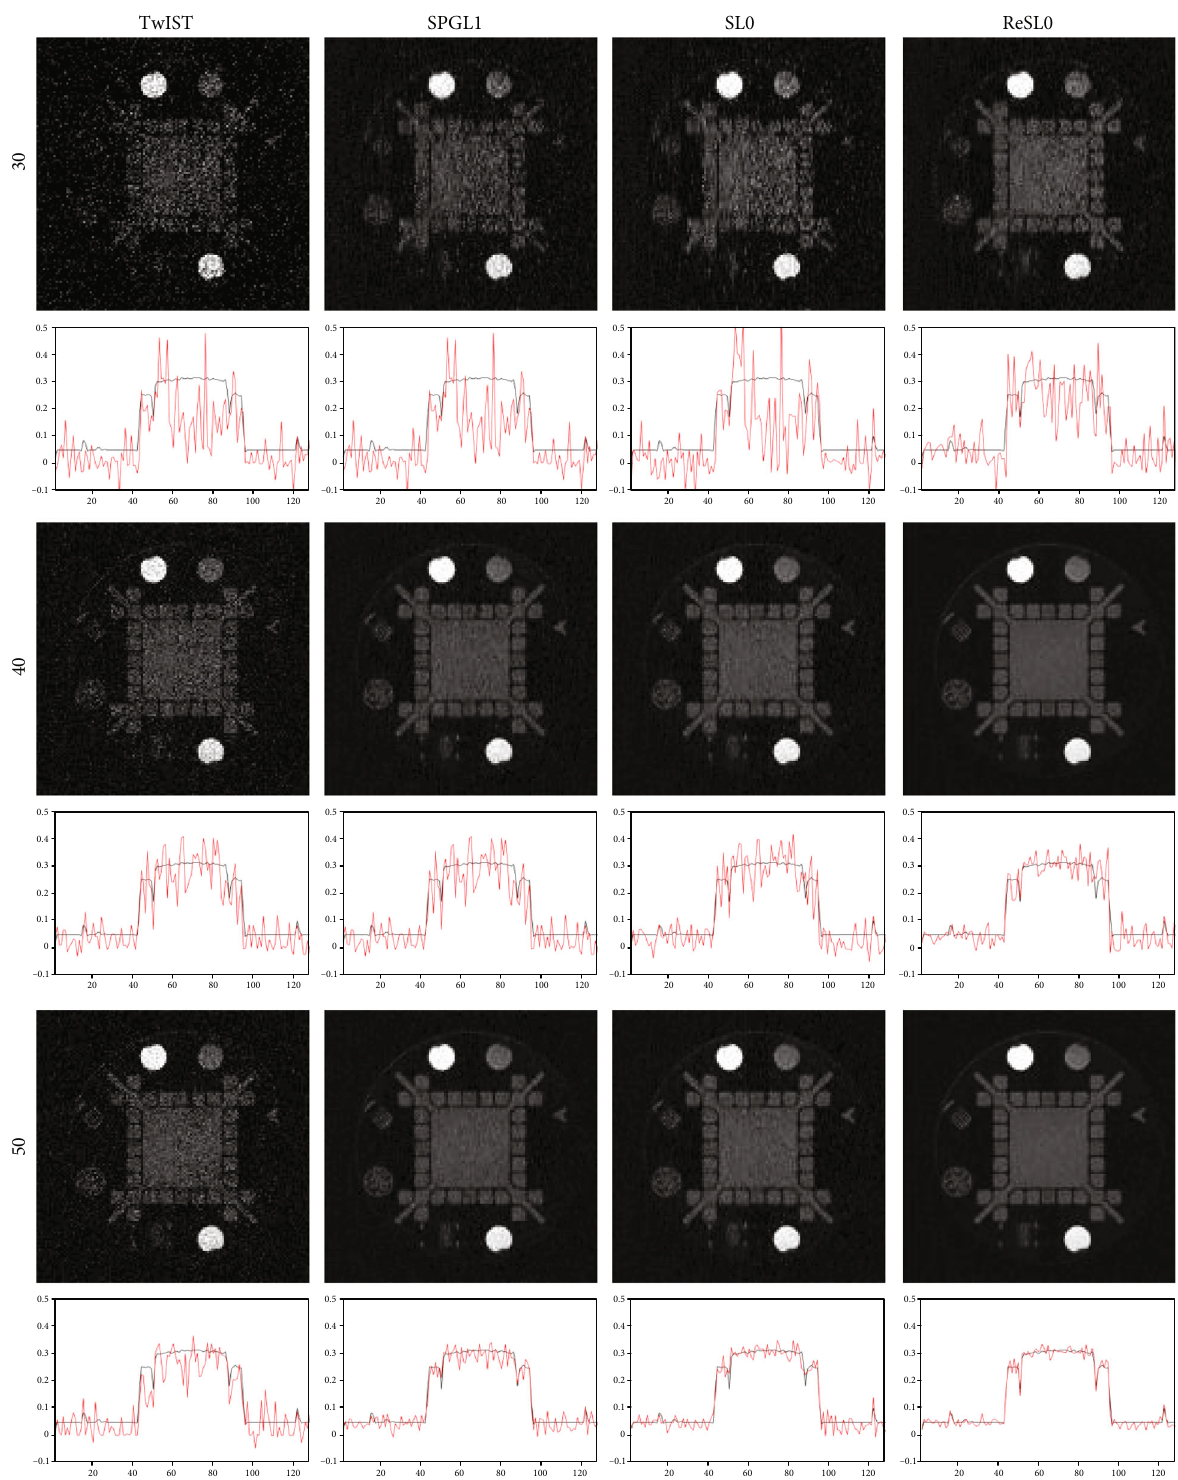
Figure 4: Reconstruction results of the standard General Electric resolution phantom. The fi rst to the third rows are the reconstruction images with 30-view, 40-view, and 50-view that are uniformly distributed at a 360 ° curve. The fi rst to the fourth columns show the results of TwIST, SPGL1, SL0, and ReSL0